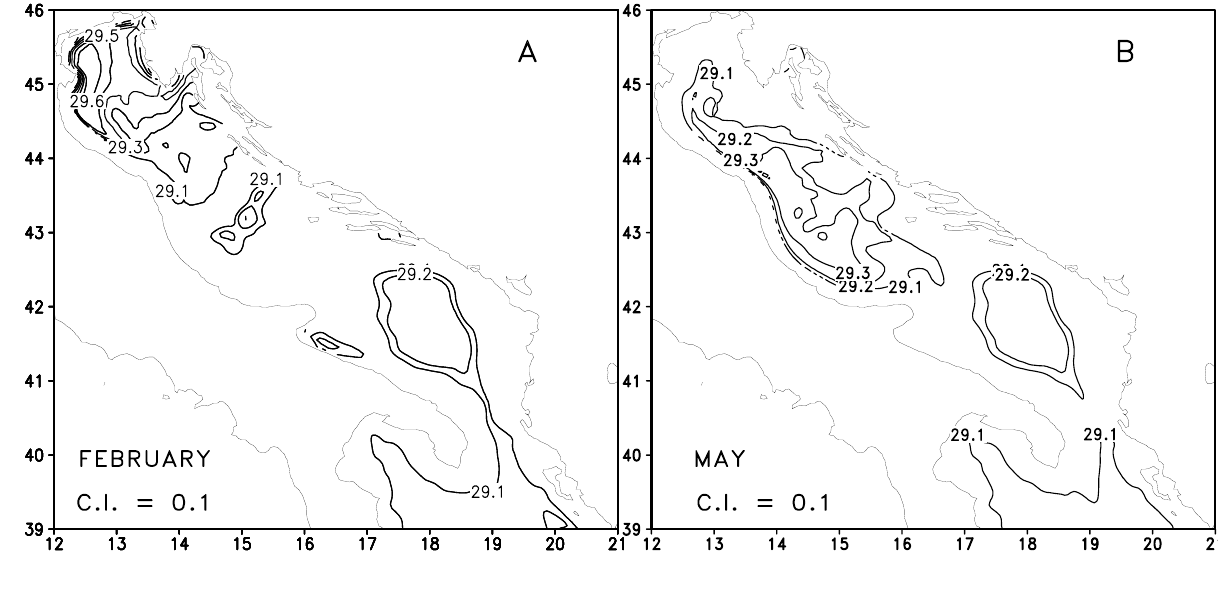
Fig. 11. Adriatic Intermediate Model (AIM). Bottom σ θ distribution. (A) : February, (B) : May. Contour interval is 0.1kg/m 3 . For clarity, σ θ values lower than 29.1kg/m 3 have been masked out.